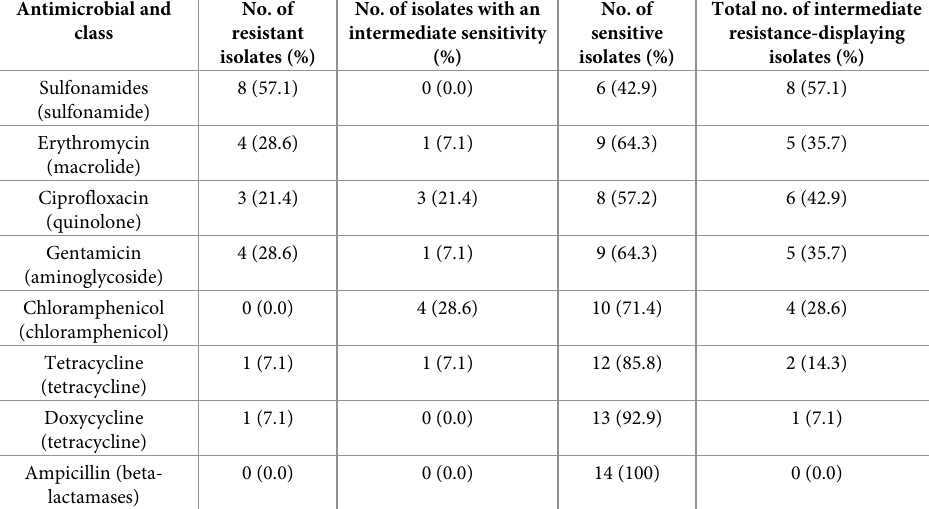
Table 3. Antibiogram constructed for 14 Listeria monocytogenes isolates obtained from poultry slaughterhouses located in the region of the Federal District and State of Goia´s, based on the results obtained via disk diffusion assay for antimicrobial resistance (CLSI,